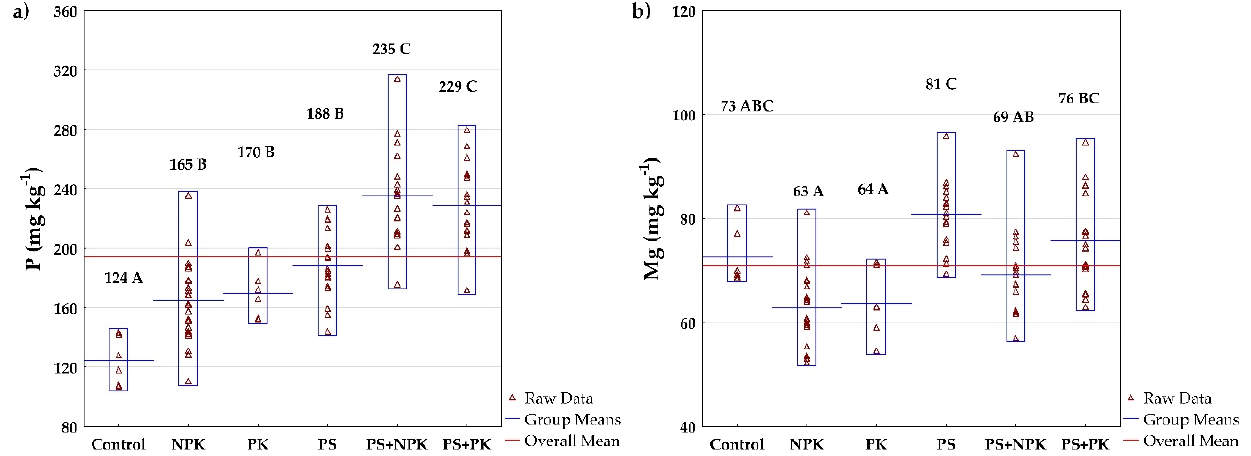
Figure 2. The effect of fertilizer treatments on ( a ) soil P and ( b ) Mg concentration in Kostelec (2015–2020). The differences between P and Mg concentrations as affected by fertilizer treatment were insignificant in Pernolec (Table 6). Mean values followed by the same letter are not significantly different. Red triangles represent the raw data. The blue lines represent the mean value of the particular treatment, while the red line represents the mean value calculated from all fertilizer treatments.